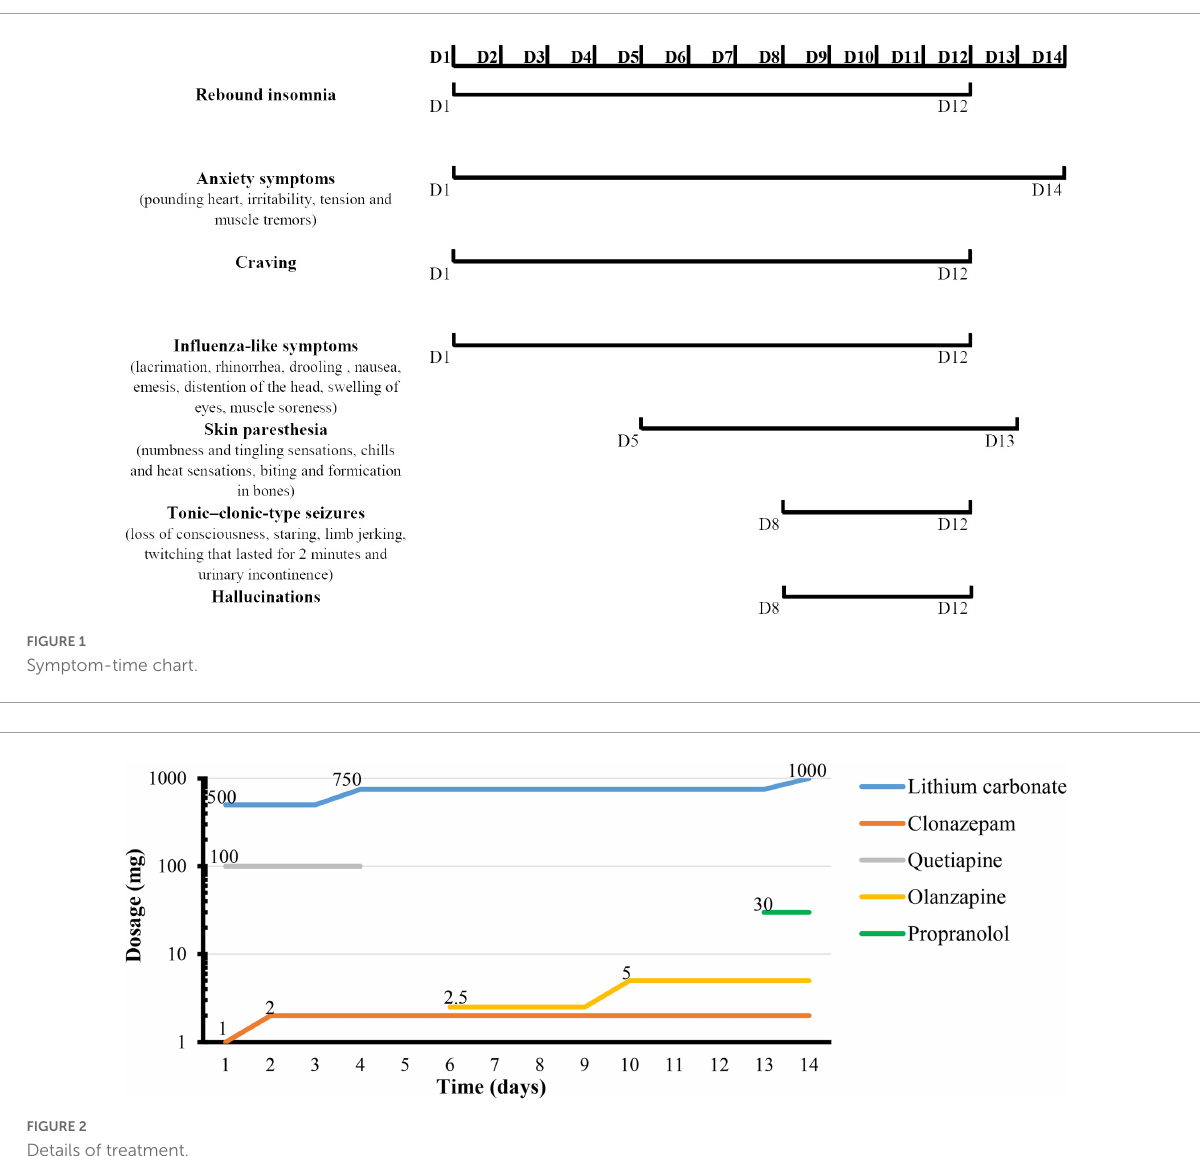
FIGURE2 Details of